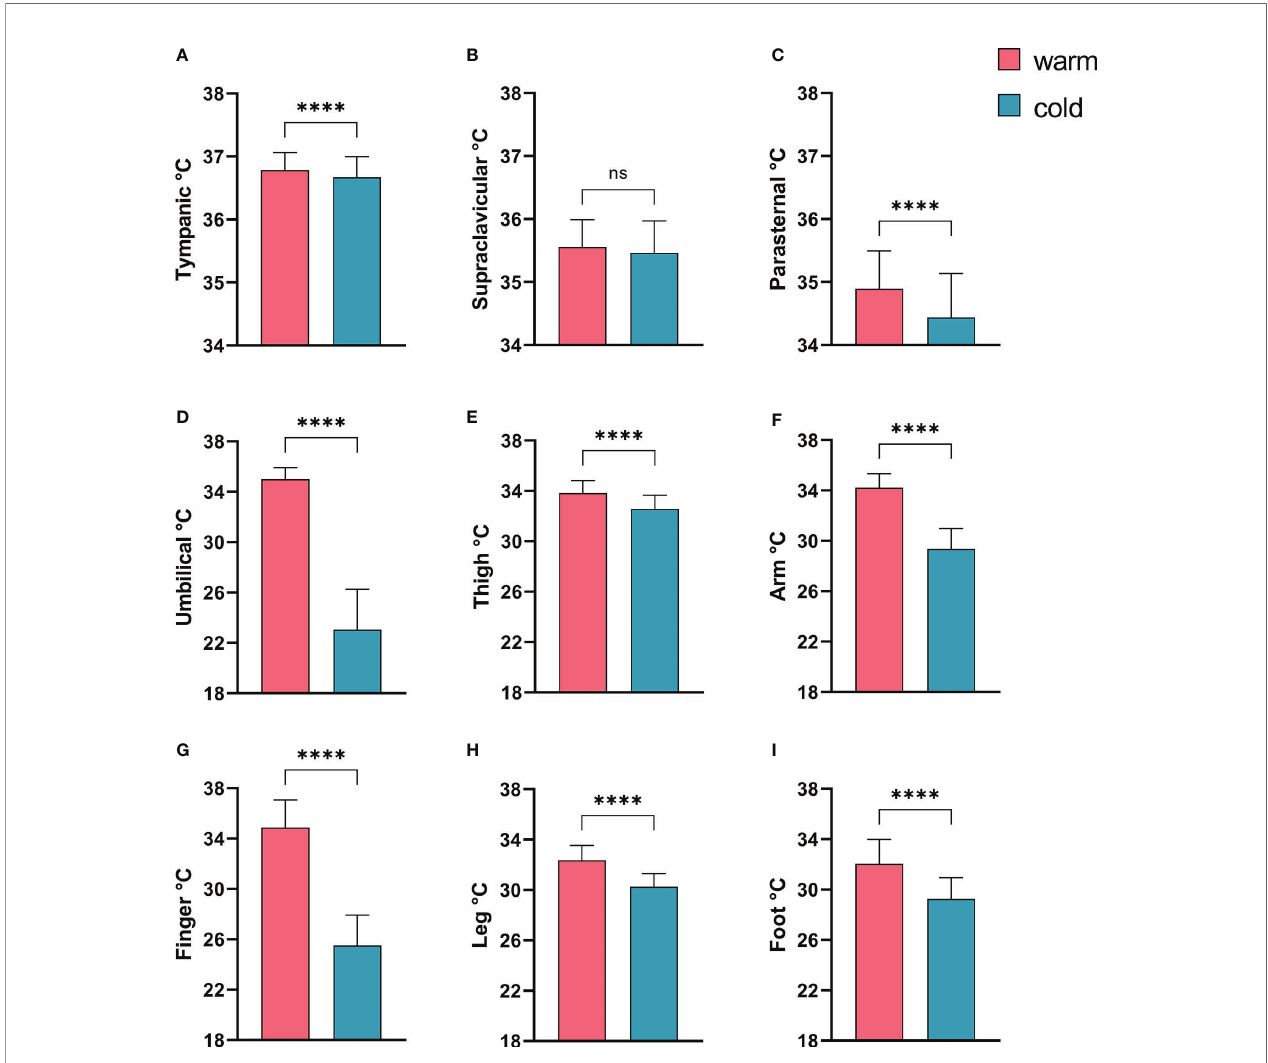
FIGURE 1 | Comparison of tympanic temperature and skin temperatures before and after mild cold exposure. (A) Tympanic temperature; Skin temperatures: (B) Supraclavicular region; (C) Parasternal region; (D) , Umbilicus; (E) Thigh; (F) Non-dominant forearm; (G) Middle fi nger, non dominant hand; (H) Left lower leg; (I) Left dorsal foot. ****p<0.0001 in Wilcoxon-Signed-Rank Test, ns, p ≥